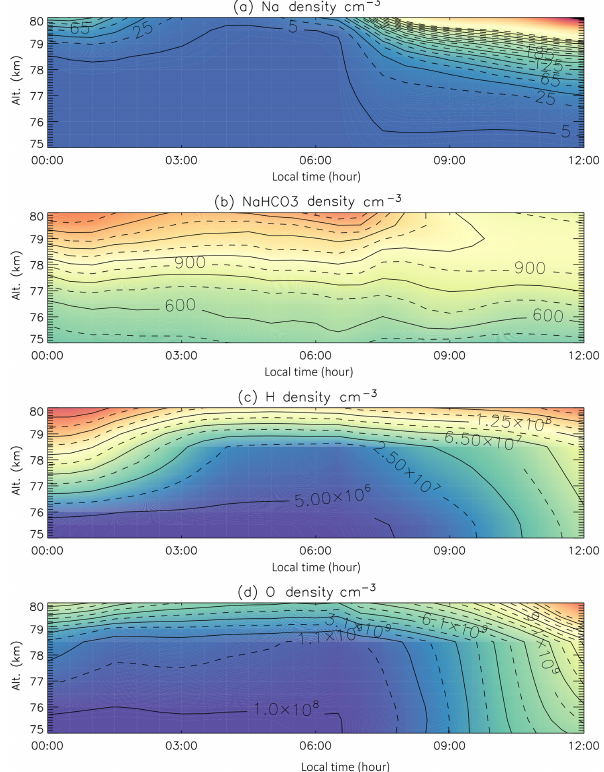
Figure 5. The variations of Na (a) , NaHCO3 (b) , H (c) and O (d) on the bottom side of the mesospheric Na layer, simulated by the WACCM_Na_144-level run.